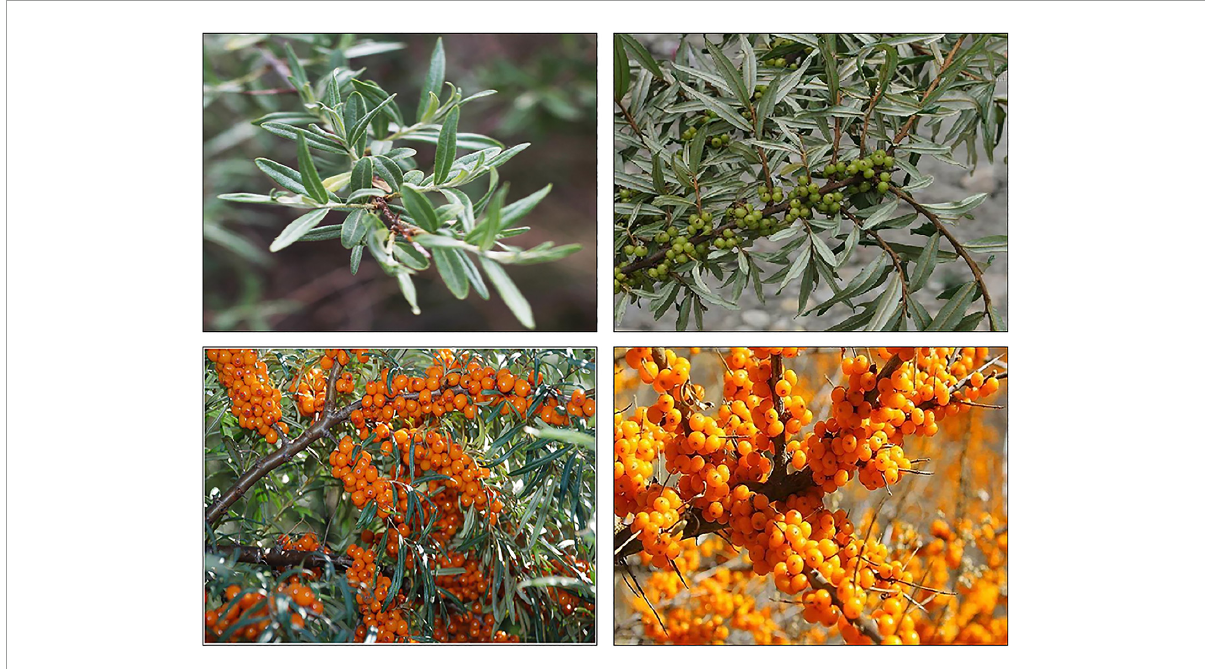
FIGURE1 Sea buckthorn in different periods.